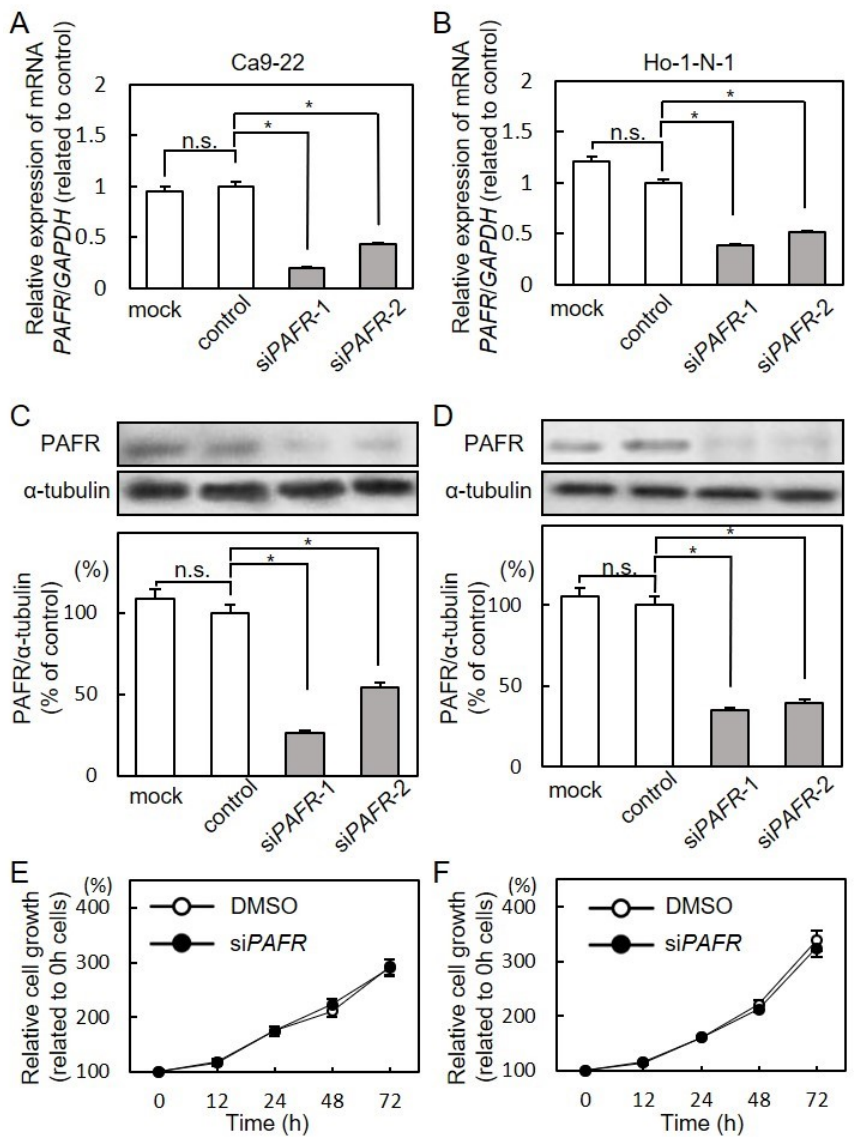
Figure 3. Effect of PAFR knockdown on cell proliferation. ( A , B ) Expression of PAFR mRNA was significantly reduced by si PAFR transfection compared with control (Ca9-22 ( A ) and Ho-1-N-1 ( B ); Unpaired t -test; *, p < 0.001; n.s., no significant difference). ( C , D ) Expression of PAFR protein was markedly reduced by si PAFR transfection compared with control (Ca9-22 ( C ) and Ho-1-N-1 ( D ); Unpaired t -test; *, p < 0.001; n.s., no significant difference). Densitometry data were normalized to α -tubulin protein levels. Values are expressed as percentages of control. ( E , F ) To determine the effect of si PAFR on cellular proliferation, si PAFR -transfected cells were seeded in 96-well plates at a density of 1 × 10 4 cells/well, followed by an assessment of cellular viability. The cells were counted at the indicated times. Cell proliferation after si PAFR transfection was not significantly different from controls (Ca9-22 ( E ) and Ho-1-N-1 ( F )). Detailed information about the Western blotting can be found at Figure S2 and Table